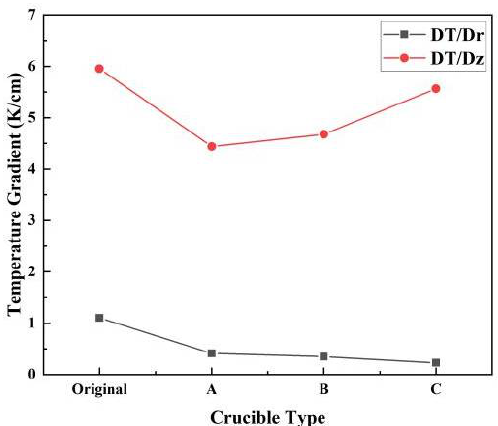
Figure 4. Temperature gradients of different types of crucibles. (DT/Dz and DT/Dr represent the axial and radial temperature gradient, respectively.)